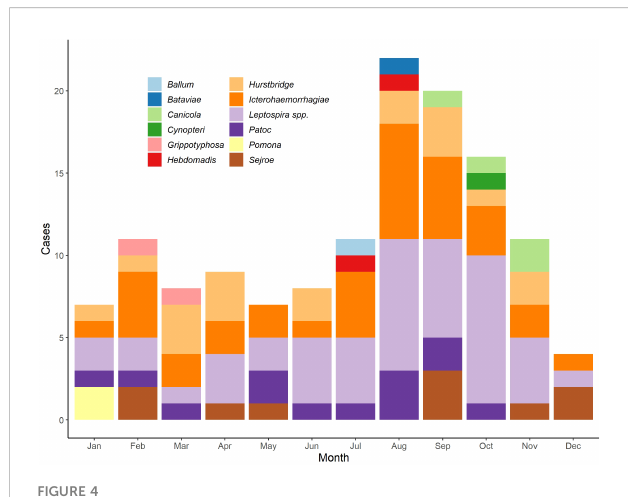
FIGURE 4 Distribution of serovars among cases of leptospirosis by month, Denmark,